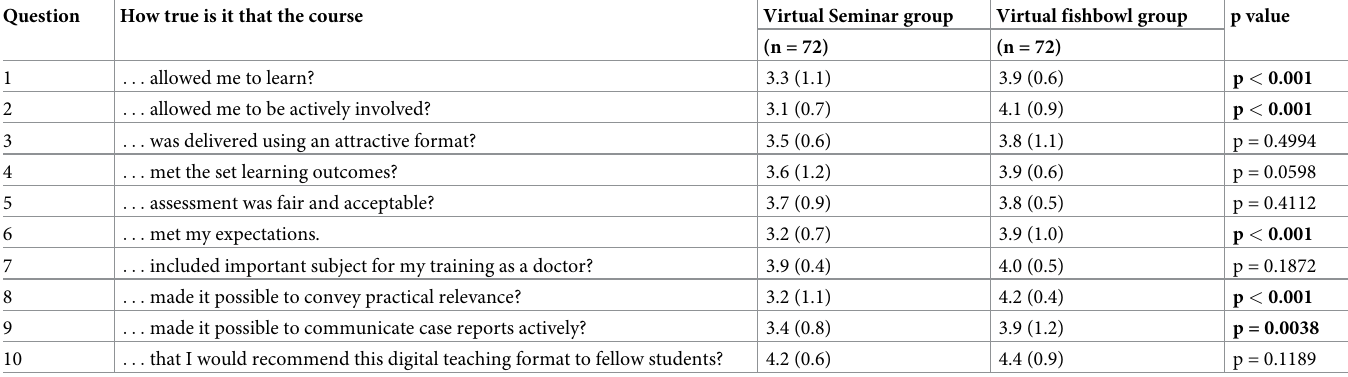
Table 1. Mean score (SD) for student’s perception questionnaire from both groups (1 = Strongly disagree, 2 = disagree, 3 = neutral, 4 = agree, 5 = Strongly agree). Student’s t-test results compared the seminar questionnaire results with those from the